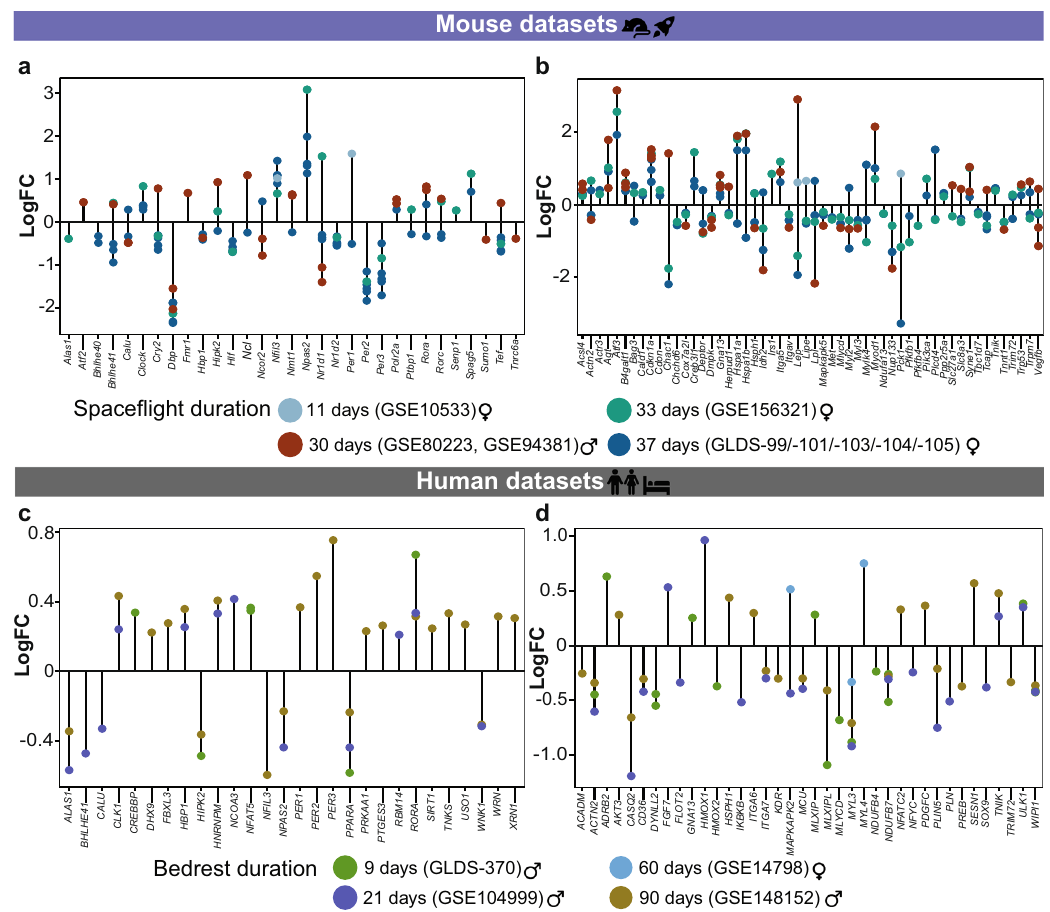
Fig. 4 Strength of alterations in clock- and muscle- related genes correlates with the duration of space fl ight/bedrest in mammalian skeletal muscle. To explore the differences in differential gene expression based on the duration of space fl ight or bedrest, we grouped the datasets accordingly. The groups for space fl ight datasets were 11 days (GSE10533), 30 days (GSE80223, GSE94381), 33 days (GSE156321), and 37 days (/GLDS-99/-101/-103/-104/-105). The groups for bedrest datasets were 9 days (GLDS-370), 21 days (GSE104999), 60 days (GSE14798), and 90 days (GSE148152). Lollipop plots represent the distribution of differentially expressed clock-regulated genes (NCRGs) and muscle related genes due to space fl ight ( a – b ) and bedrest ( c – d ),